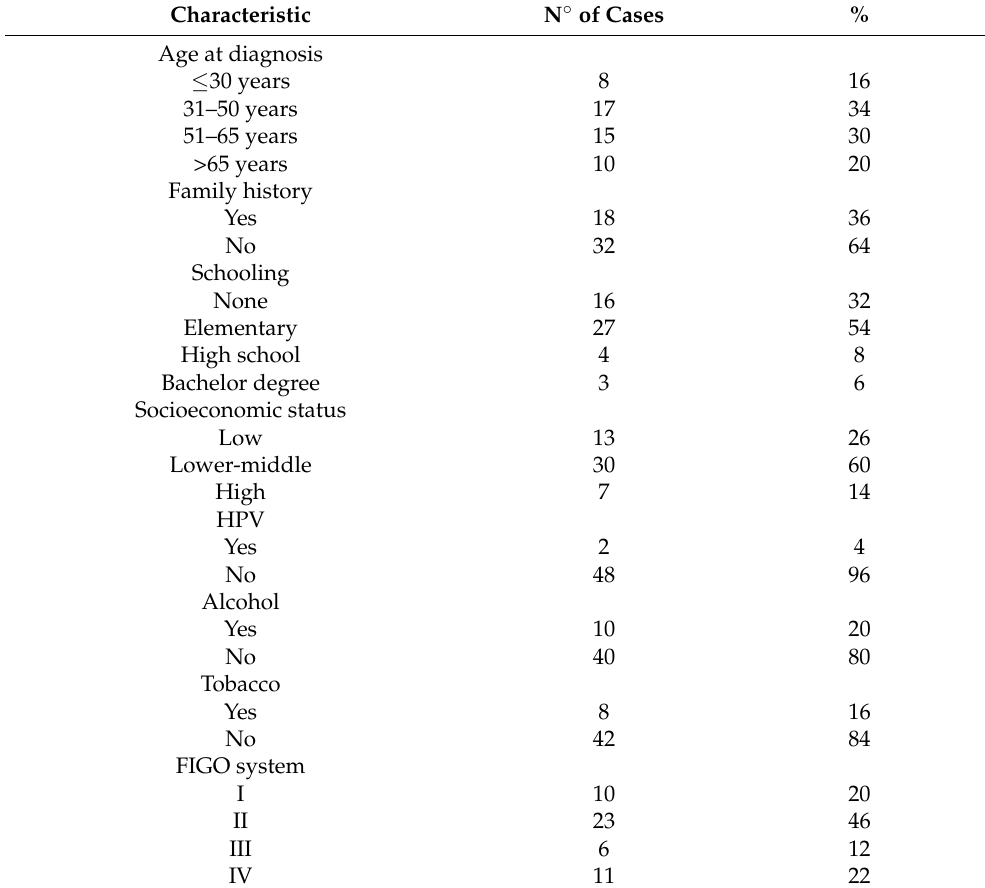
Table 4. Clinical demographic characteristics of the cervical cancer patients included in this study (n =